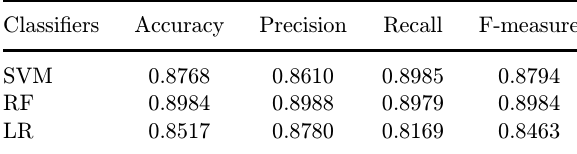
Table 4. Classi¯cation performance based on our